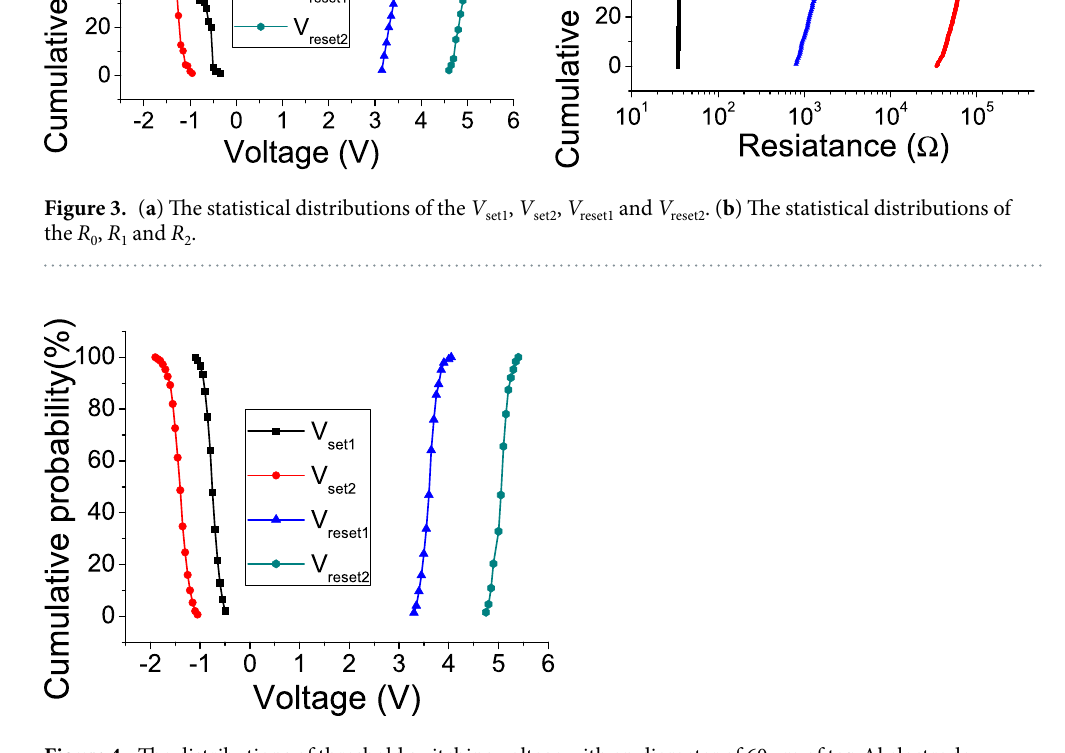
Figure 4. The distributions of threshold switching voltage with an diameter of 60 μ m of top Al